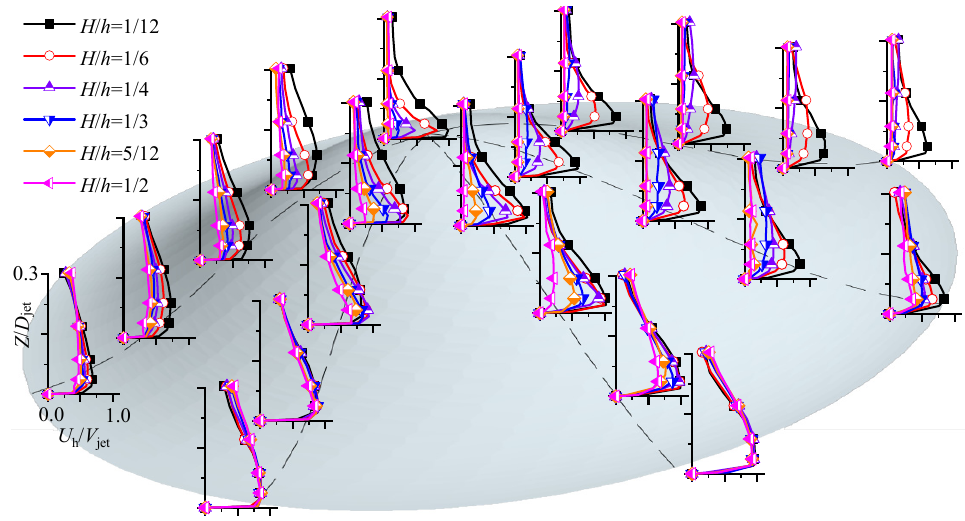
Figure 12. Profiles of horizontal wind velocity ( L = 0.5 D jet , r h = 0.8 D jet ).